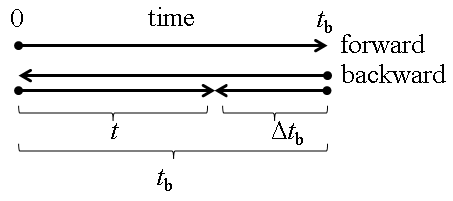
Figure 2. An outline of the time schedule of the forward and backward simulations. Forward simulation starts at Time 0 and terminates after nine days. Backward simulations start at time t b (where the value of t b can be 1,2, . . . ,9 days) and terminate at Time 0. The comparison of the forward and backward cloud is carried out at time t ( t = 0,1, . . . , t b − 1 days) as a function of the time period ∆ t b of the backward